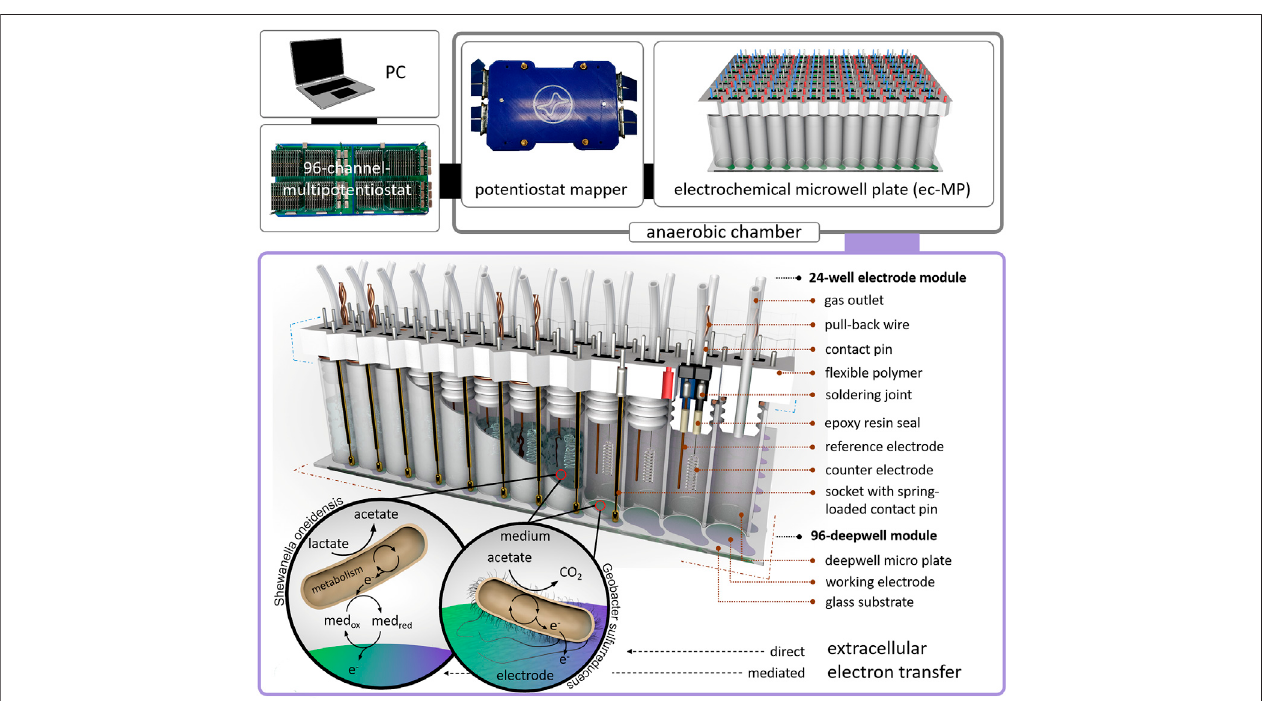
FIGURE 1 | Design of the electrochemical microwell plate (ec-MP): The ec-MP consists of a 96-deepwell module and up to four 24-well electrode modules connected to a 96-channel multipotentiostat by a potentiostat mapper. In this study microbial electrochemical activity of S. oneidensis and G. sulfurreducens is measured as an example. Photographic images of single components can be found in Supplementary Figure S1